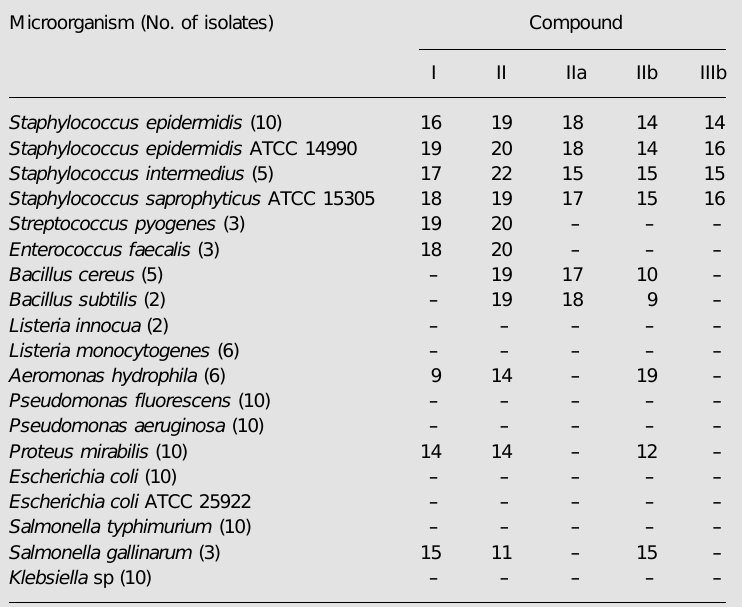
Data indicate the inhibition zone in mm and are the mean of five determinations for each isolate. Strains of S. pyogenes and E. faecalis were grown on Mueller-Hinton agar supplemented with 5% sheep blood; all other strains were grown on Mueller-Hinton